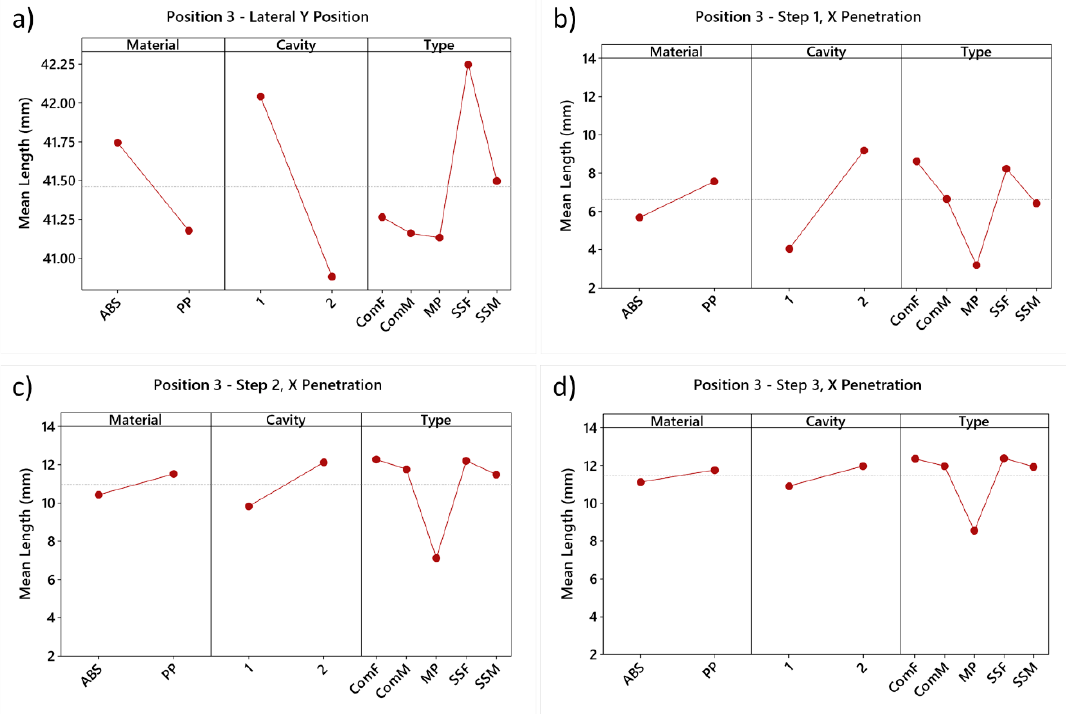
Figure 5. ( a ) Main effects plots for Y length, measure of the accuracy of the position selection, relatively to material, cavity, and type of experiment; ( b ) Main effects plots of the degree of penetration X in Step 1 (thickness = 1.25 mm for cavity 1 and 1.20 mm for cavity 2); ( c ) Main effects plots of the degree of penetration X in Step 2 (thickness = 1.00 mm for cavity 1 and 0.90 mm for cavity 2); ( d ) Main effects plots of the degree of penetration X in Step 3 (thickness = 0.75 mm for cavity 1 and 0.60 mm for cavity 2). Reproduced with permission from [18].